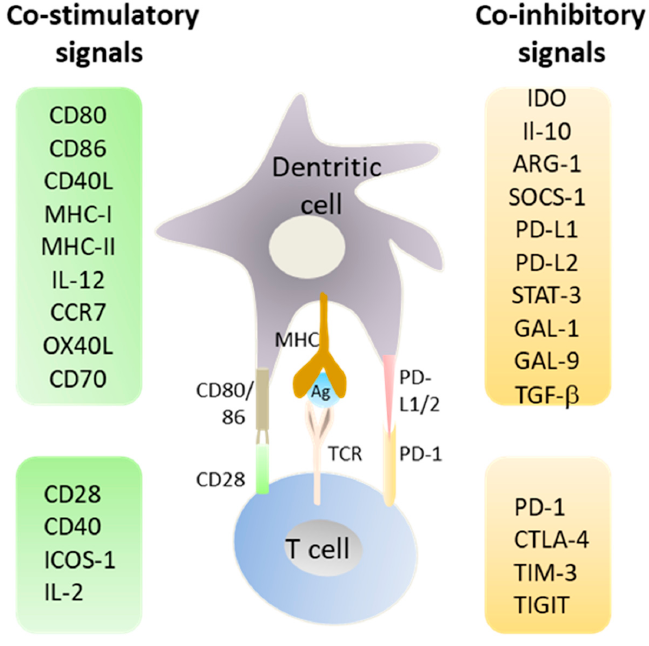
Figure 1. Important role of dendritic cells in deciding immunity versus tolerance. Dendritic cells express several co-stimulatory factors (e.g., CD80, CD86, CD40, IL-12, CCR7) that facilitate T cell activation. To regulate the magnitude of immune responses, dendritic cells DCs also express co-inhibitory molecules such as programmed cell death protein 1 (PD-1) ligands, indoleamine 2,3-dioxygenase ( IDO), and IL-10. Antigen presentation by DC without an additional co-stimulatory signal (e.g., CD80/CD86), or in combination with a co-inhibitory signal (e.g., PD-L1/2) can lead to tolerance induction. Studies in the field of T cell regulation identified the cytotoxic T lymphocyte-associated antigen 4 (CTLA-4) and PD-1 as inhibitory pathways that restrain T cells from full and persistent activation and proliferation under normal physiologic conditions.